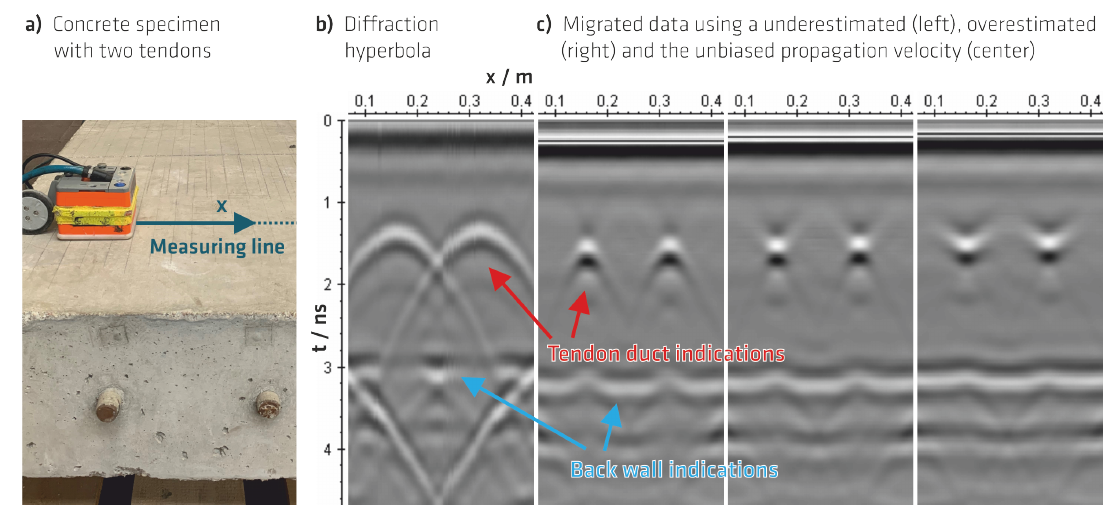
tendon indications in the specific case outlined in